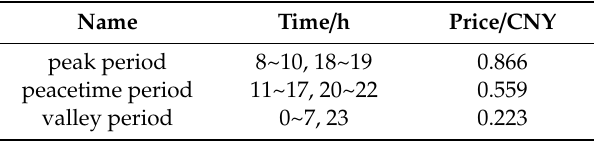
Table 1. Time-of-use tariff.